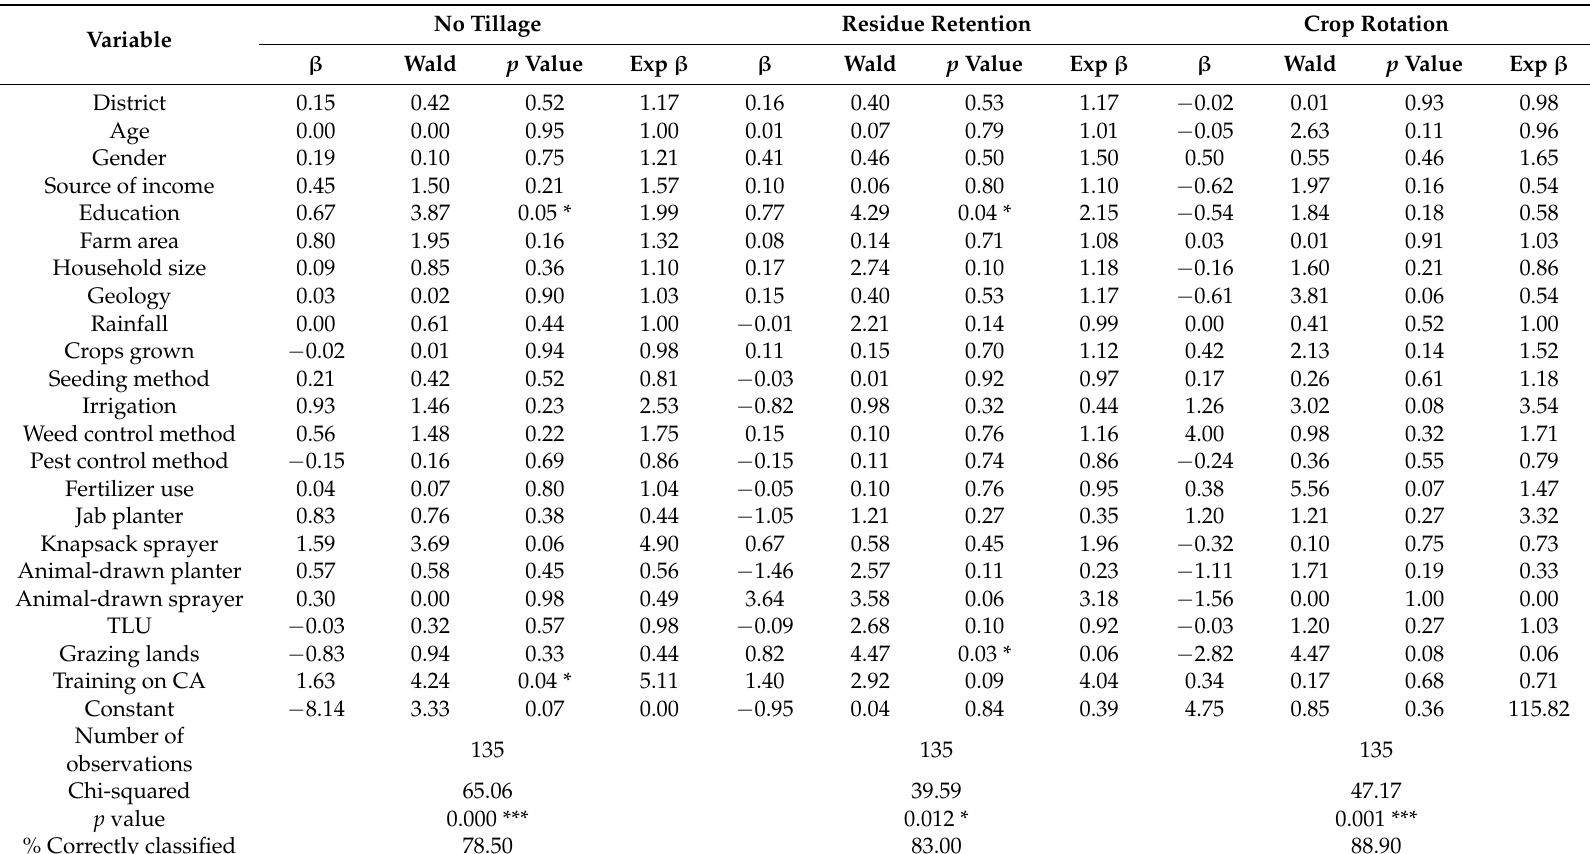
Table 3. Binary logistic regression of factors influencing farmers’ decision to practise conservation agriculture (CA) components.